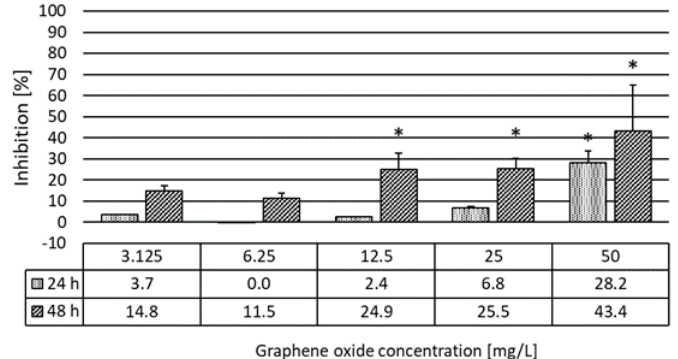
Figure 6. The effect of graphene oxide on the heartbeat rate of D. magna after 24 and 48 h of exposure. Significant effect compared to control is marked by asterisk (*).